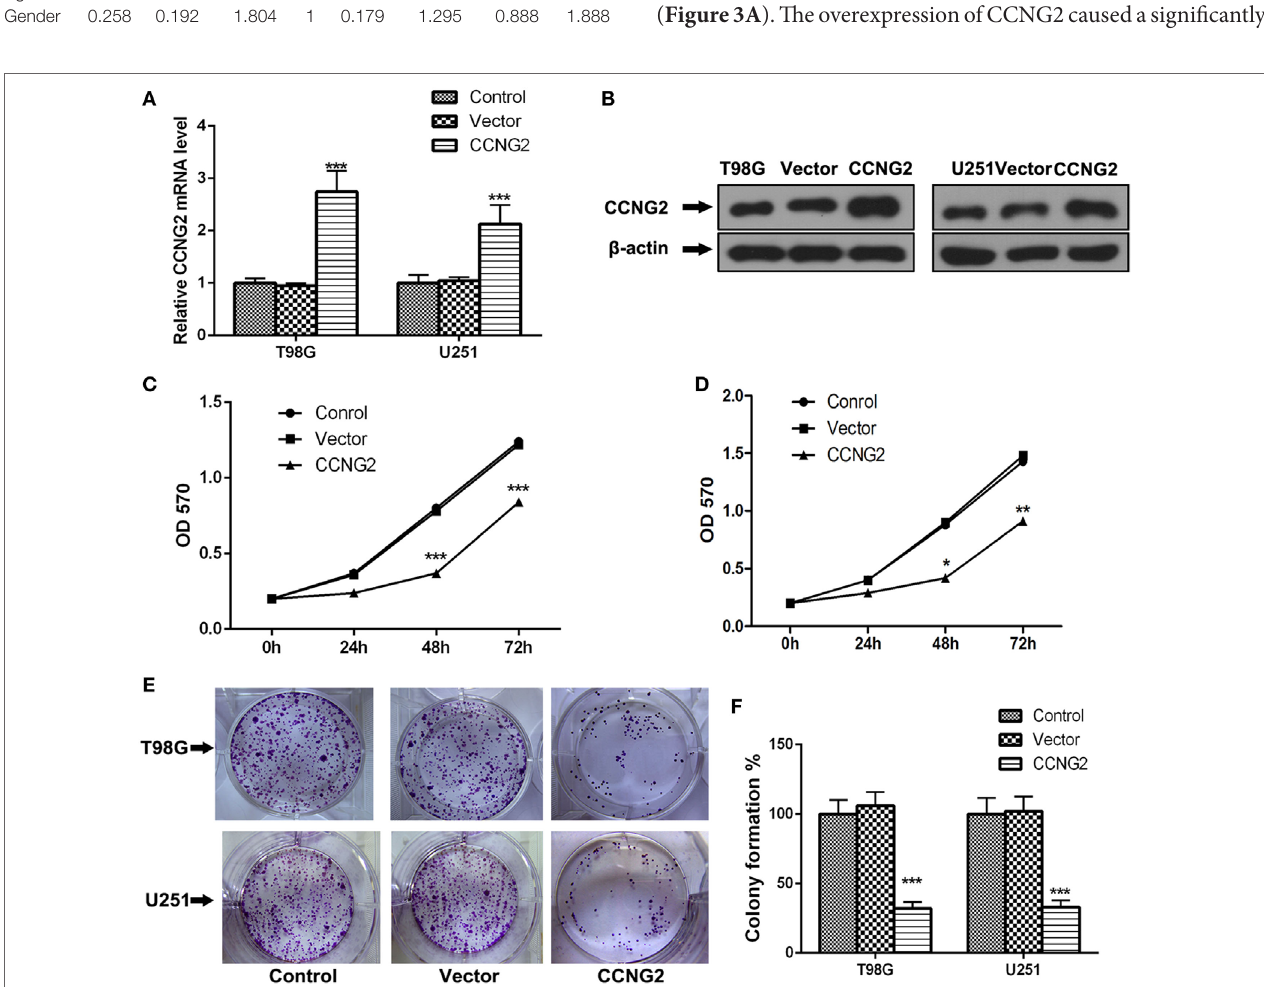
FigUre 2 | Overexpression of CCNG2 inhibits cell proliferation in T98G and U251 cells. (a,b) RT-PCR and western blot detection of CCNG2 expression levels in T98G and U251 control cells or cells transfected with CCNG2 or vector. Cell proliferation was detected by MTT assay in (c) T98G and (D) U251 control cells or cells transfected with CCNG2 or vector. (e,F) Colony formation assays in T98G and U251 cells showed that CCNG2 overexpression resulted in a significant decrease in colony number compared with the control groups. Data were expressed as means ± SEM ( n = 3).* P < 0.05, ** P < 0.01, *** P < 0.001 by unpaired two-tailed Student’s t